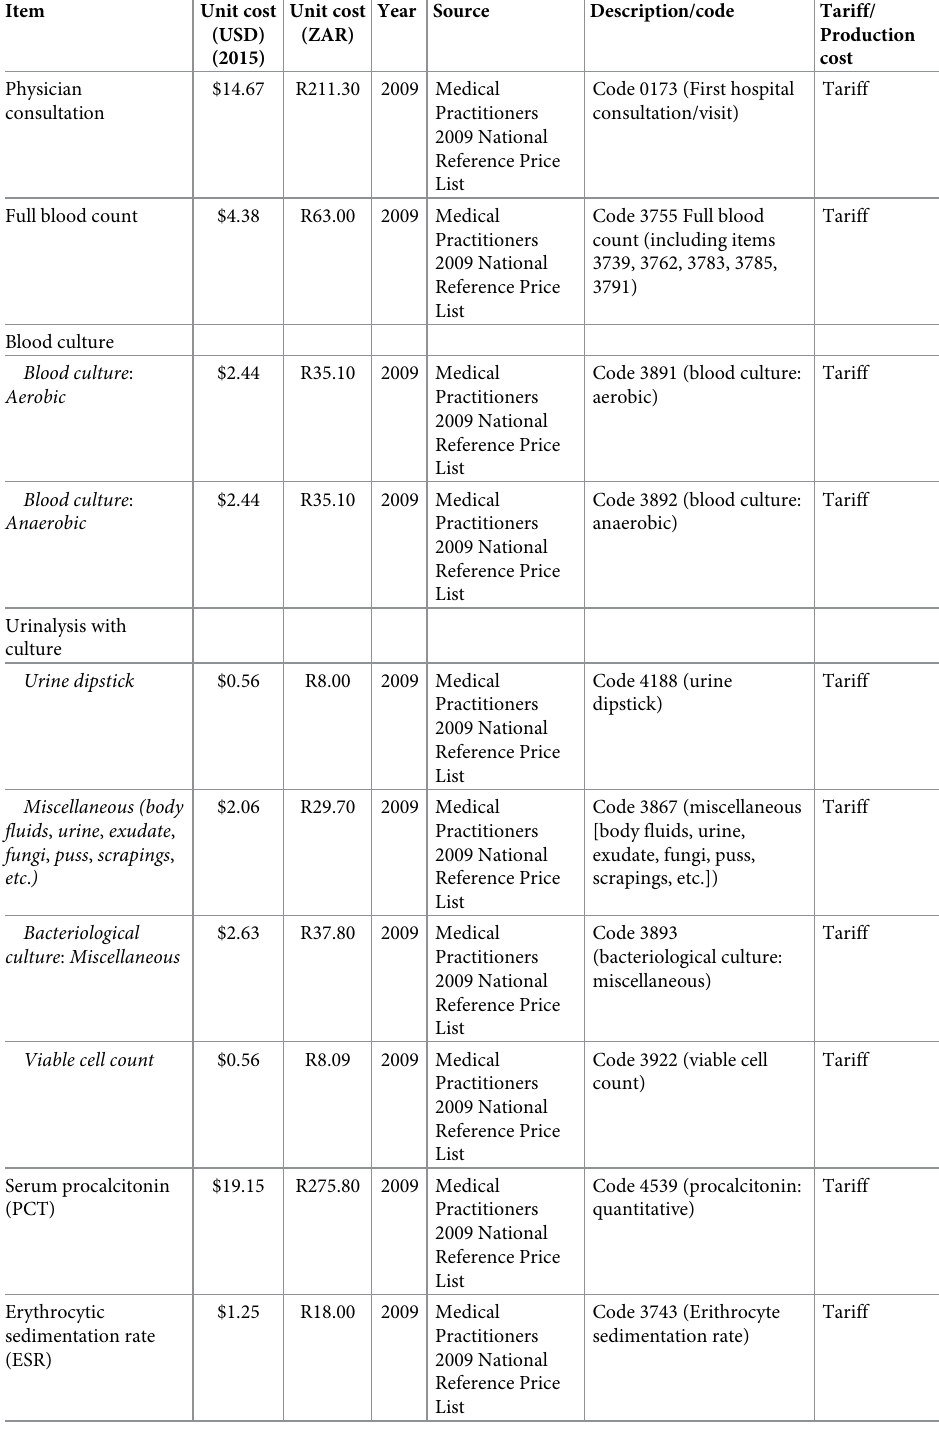
Table 6. Cost details for private health care sector